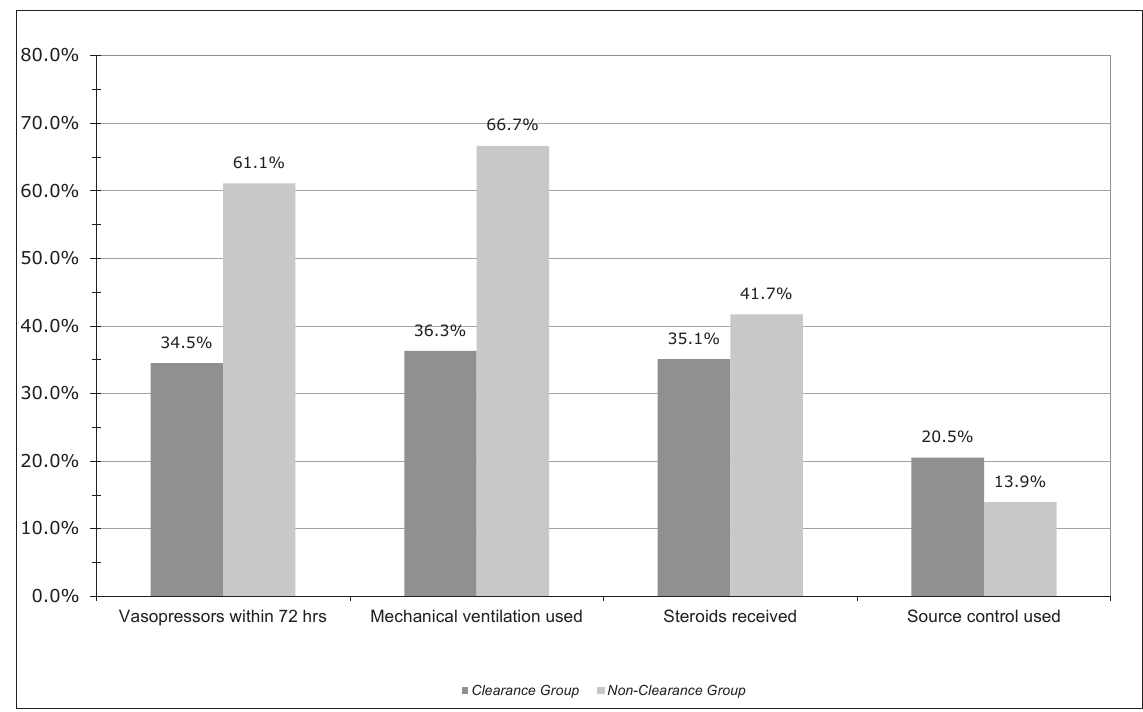
Figure 1. Hospital interventions for clearance and non-clearance groups. A significantly higher ratio of patients in the non-clearance group required vasopressor support within 72 hours of admission compared with the rate of vasopressor use in the clearance group (p<0.01). A greater percentage of patients in the non-clearance group required mechanical ventilation for any point during the hospitalization (p=0.001). There were no significant differences in the rates of steroid use or source control between clearance and non-clearance groups.